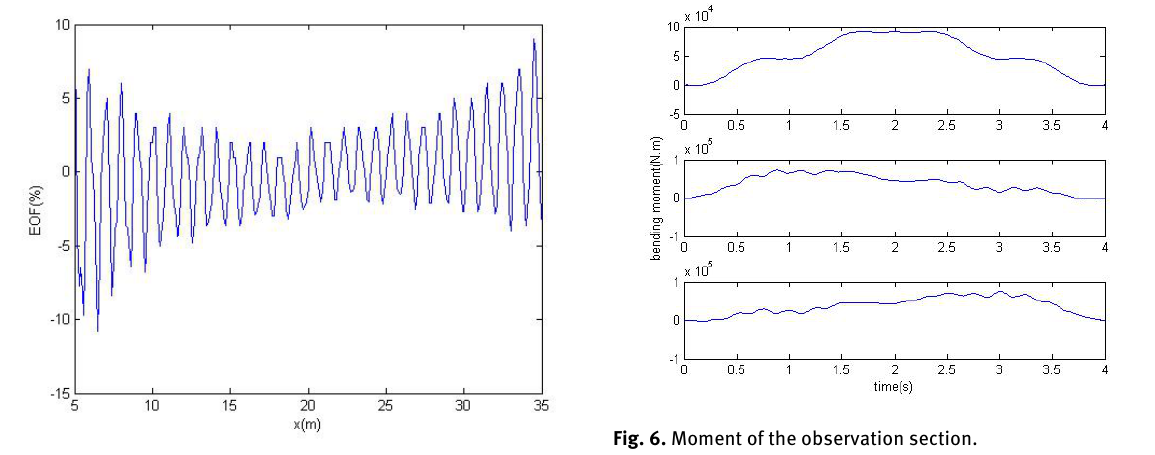
Fig. 6. Moment of the observation section.